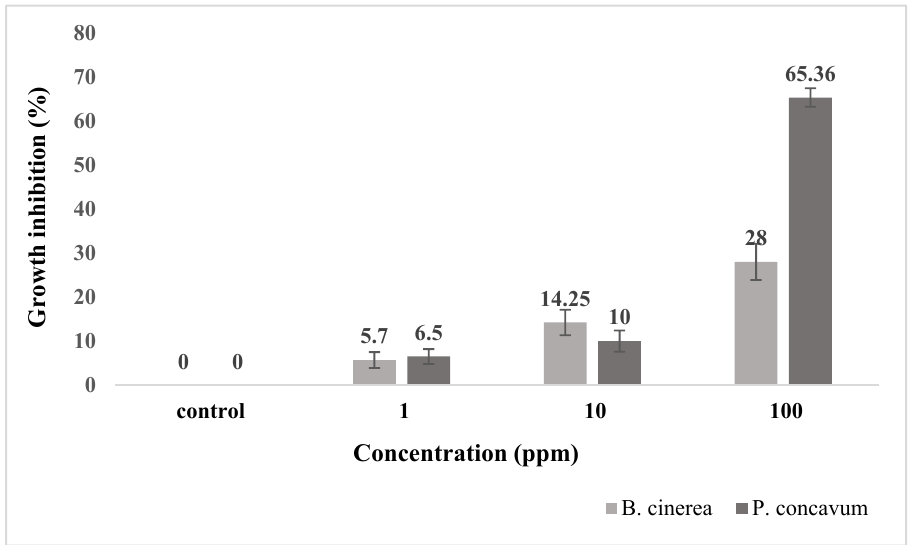
Figure 1. Growth inhibition percentage of B. cinerea and P. concavum treated with different concentrations of the synthesized Ag NPs for 9 days. Data are presented as mean ± SD of three replications.